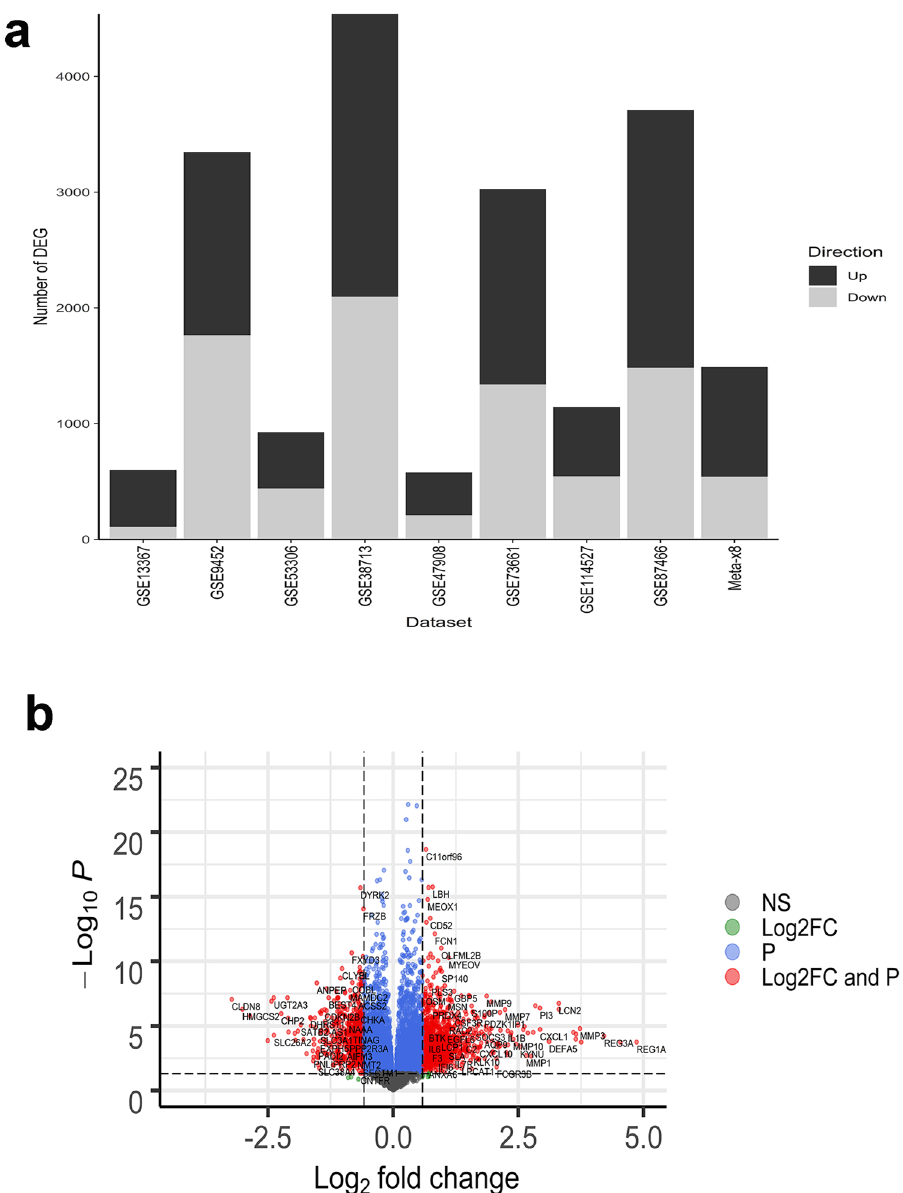
Figure 1. ( a ) Differentially expressed genes (up- or down-regulated log2-fold change [log2-FC] > 0.58 with adjusted P value < 0.05) for individual datasets and meta-analysis (Meta- × 8). Multiple Probesets for the same gene were summarized at Gene Symbol level (and counted as 1 differentially expressed gene). ( b ) Meta-analysis volcano plot of genes up- or down-regulated in ≥ 6 datasets. Dots to the left of 0 on the X-axis represent genes whose expression is lower in UC patients compared to healthy controls, whereas dots to right of 0 on X-axis represent genes whose expression is higher in patients with UC compared to healthy controls. Gray dots represent genes that do not meet the criteria for log2 fold change (FC) > 1.5 (up or down) or significant adjusted P value < 0.05. Green dots represent genes that meet the criterion for log2 FC > 1.5 (up or down) but not adjusted P value < 0.05. Blue dots represent genes with adjusted P value < 0.05 but not log2 FC > 1.5 (up or down). Red dots represent genes that meet both the log2 FC > 1.5 (up or down) and adjusted P value < 0.05 criteria. The horizontal dashed line is located at a value equivalent to the adjusted P value (0.05). Vertical lines are located at + and − 1.5 log2